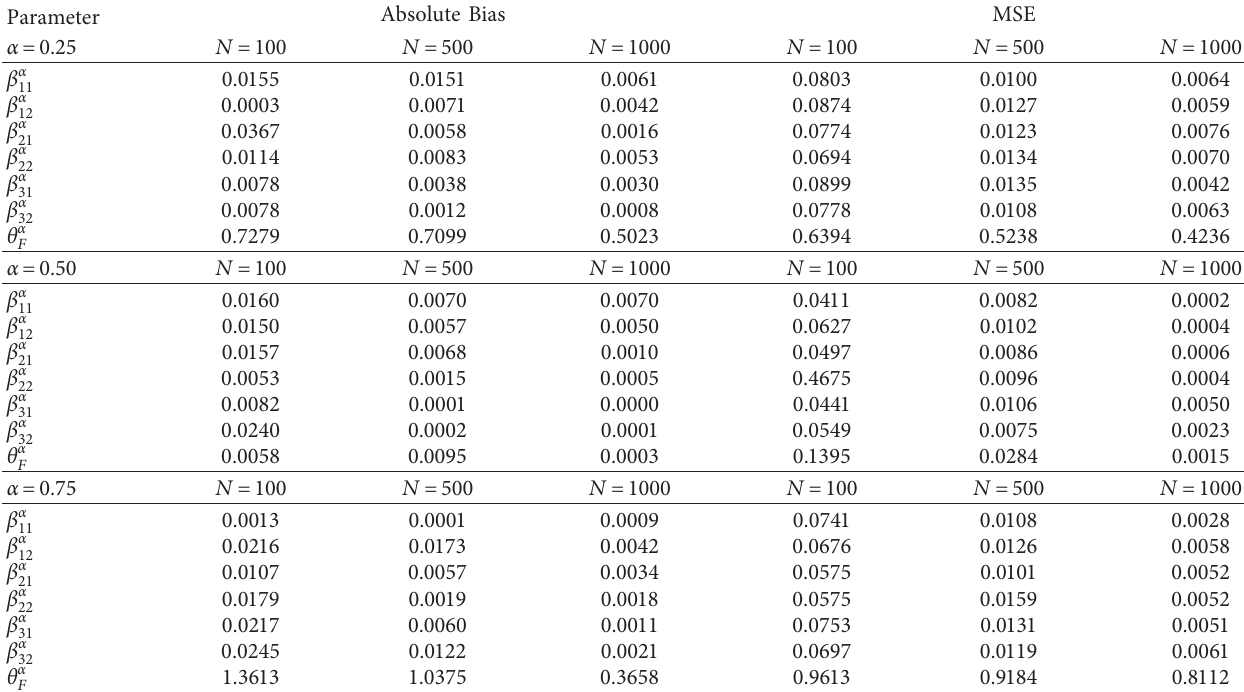
Table 6: Absolute Bias and MSE of parameter estimates from the Bayesian estimation of the Frank copula with different sample sizes. Parameter Absolute Bias MSE α � 0.25